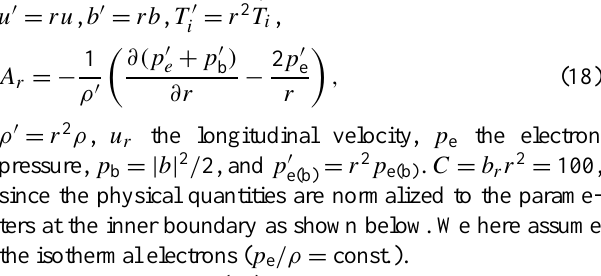
vation of magnetic flux. Note that u r > V A = b r /